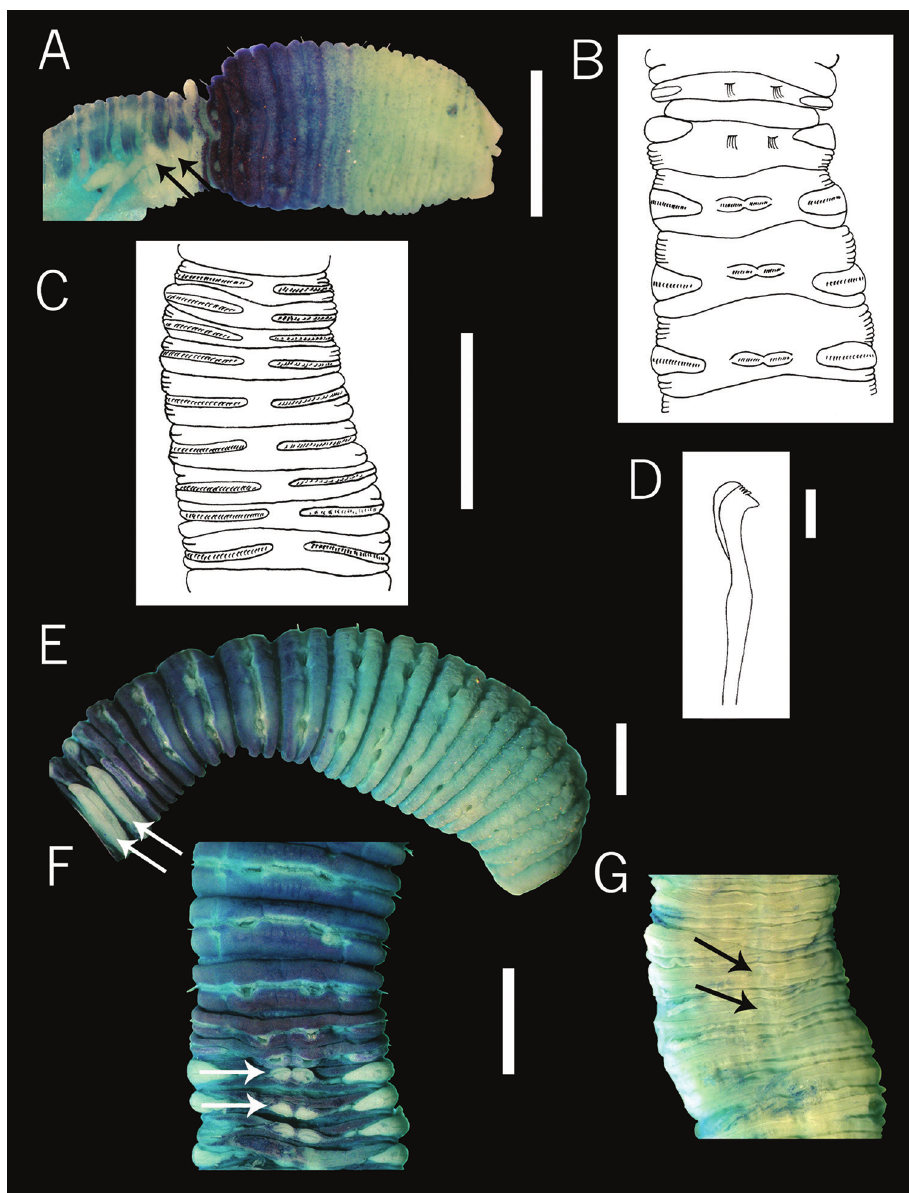
Figure 1. Holotypes of Dodecaseta oraria McCammon & Stull ( A–D ), and Notodasus kristiani (García- Garza et al., 2009) ( E–G ). A anterior end, lateral view B chaetiger 12-16, dorsolateral view C chaetigers 36-46, ventral view D neurohook from chaetiger 88, lateral view E anterior end, lateral view F chaetigers 9-17, dorsal view G chaetigers 19-27. Methyl green stain A–C, E–G . Scale bars: A, B, C, E, F, G = 1 mm, D =